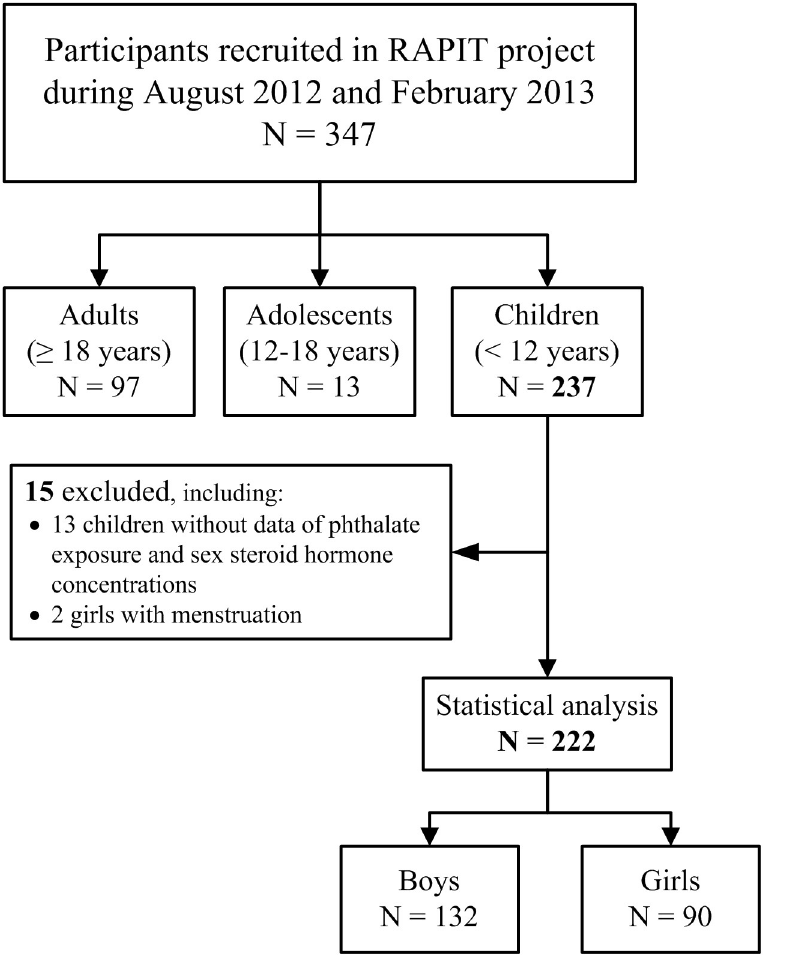
Fig 1. Flow chart of participant